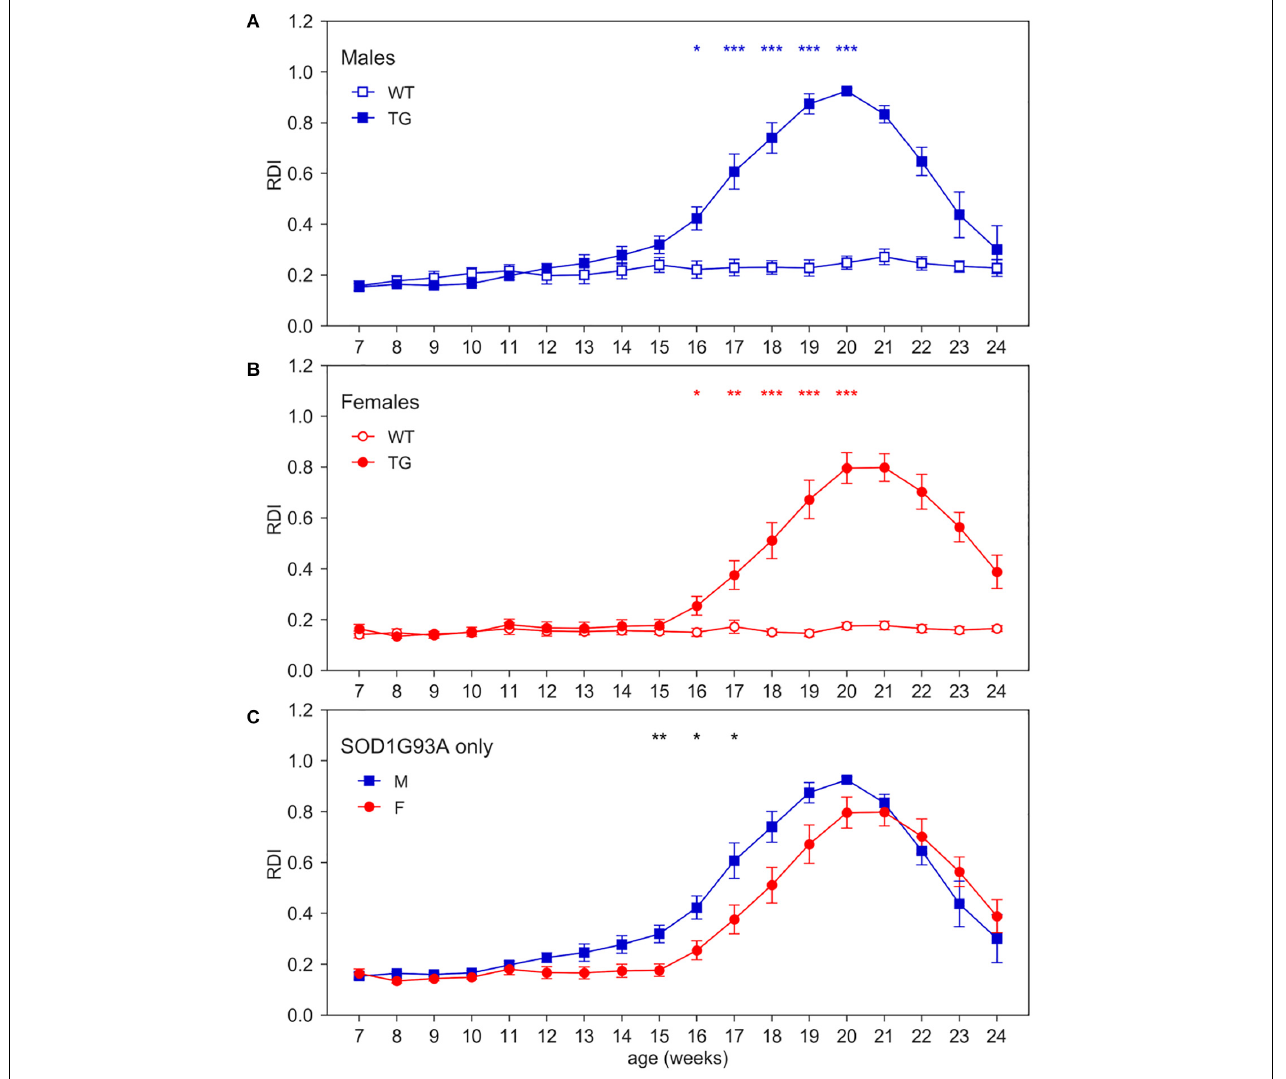
FIGURE 4 | Day-time Regularity Disruption Index (RDI). Average weekly RDI curves ( ± SEM) across 7–24 weeks of age in (A) males, (B) females, (C) TG males and females measured during day time. N of cages per group: M WT = 8; M TG = 9; F WT = 11; F TG = 10. In males (A) and females (B) * p < 0.05, ** p < 0.01, *** p < 0.001 WT vs. TG, D/AP post-hoc procedure. Since we found a significant Genotype X Sex X Age interaction (nparLD test, Genotype X Sex X Age interaction: Statistic = 3.084, df = 6.429, p < 0.01), we compared TG males with TG females with D/AP post-hoc procedure in (C) (* p < 0.05, ** p < 0.01, black